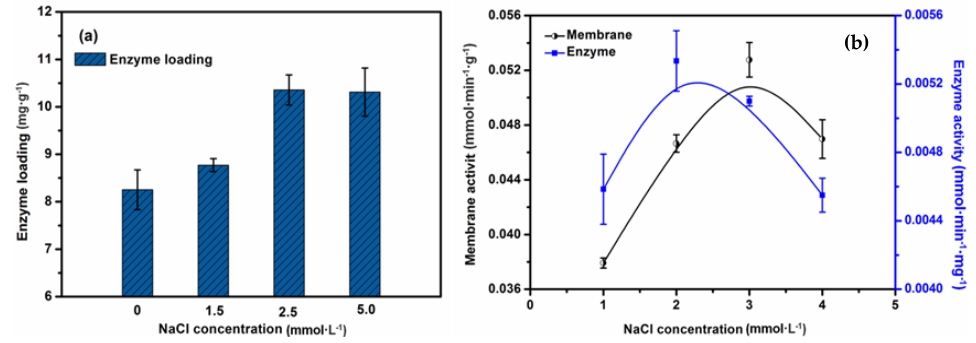
Figure 7. Effect of ion strength on the enzyme loading ( a ) and the activity of EMBR and enzyme ( b ).